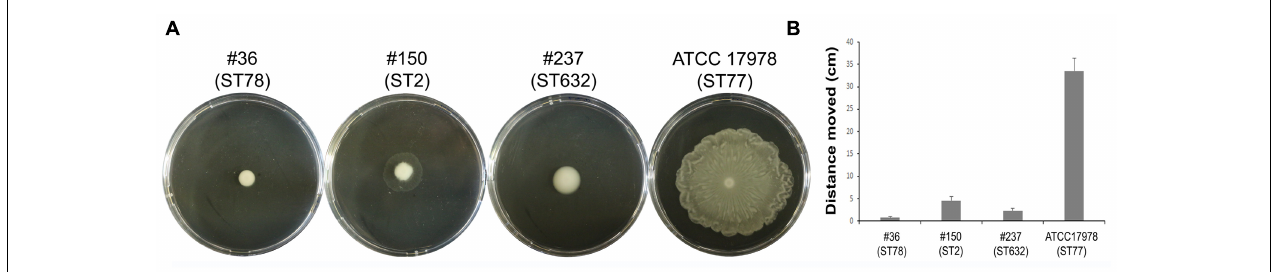
FIGURE 3 | Motility of CRAb on agar plates. A representative picture of the motility pattern of each isolate is reported (A) . The distance migrated (diameter) for each strain was measured (B) ; data are means ± standard deviation from at least three independent experiments, in duplicate ( P -value < 0.01).